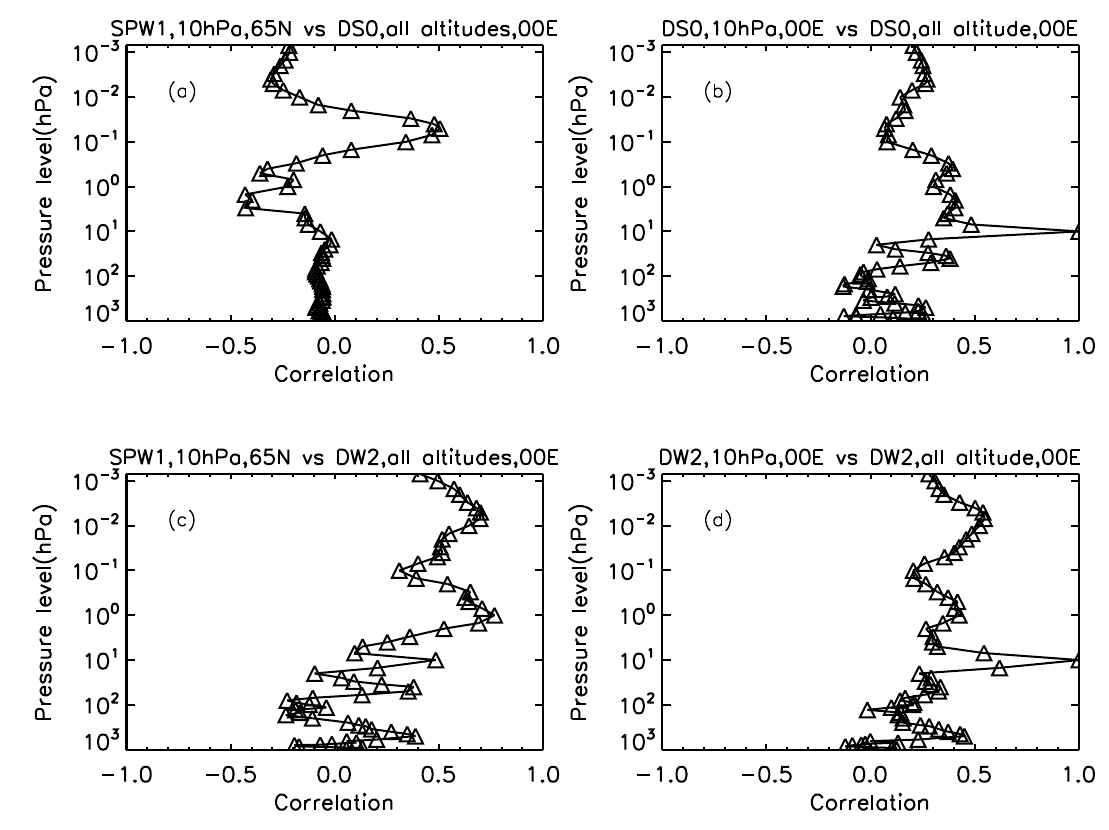
Figure 11. Correlation between amplitudes of ( a ) high-latitude stratospheric SPW1 with equatorial DS0, ( b ) equatorial DS0 at 10 hPa with equatorial DS0 at all altitudes, ( c ) high-latitude stratospheric SPW1 with equatorial DW2, ( d ) equatorial DW2 at 10 hPa with equatorial DW2 at all